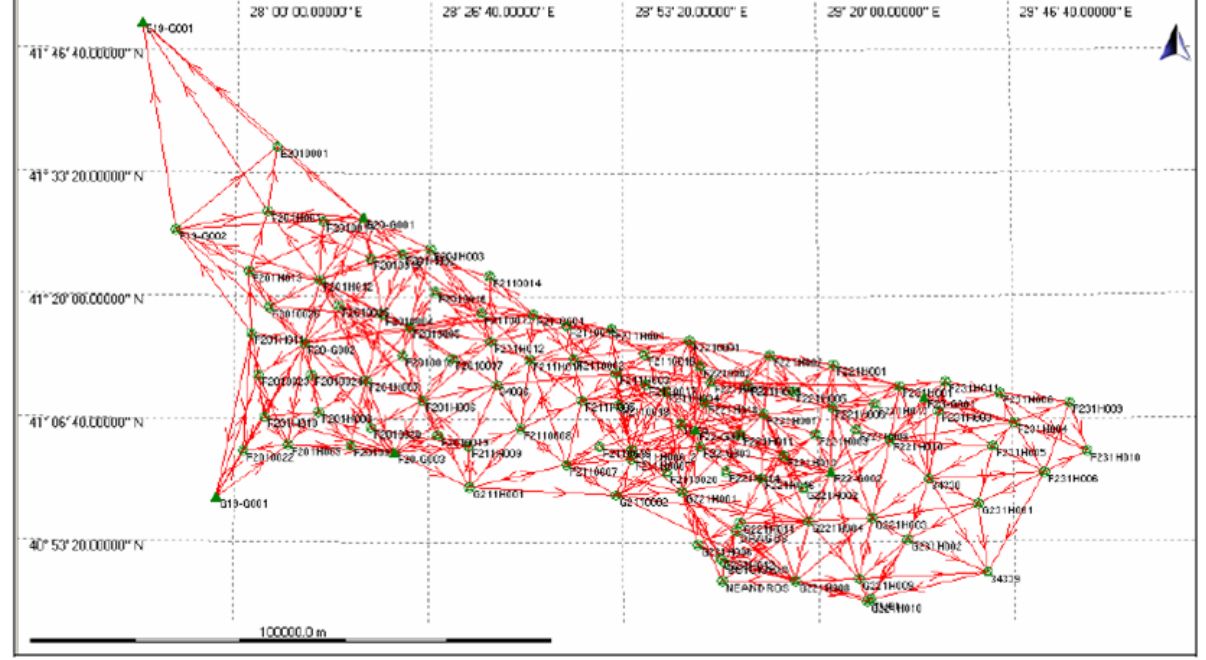
Fig. 4. IGNA Primary GPS Network 2005 (Ayan et al.,